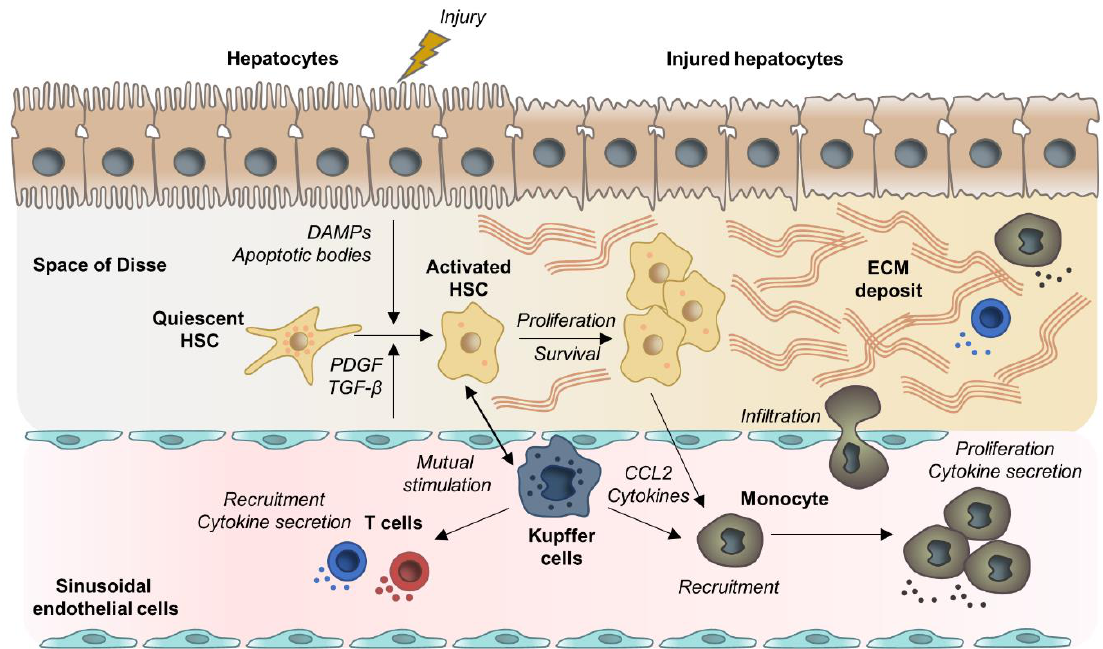
Figure 1. Examples for mechanistic concepts for liver fibrosis. Chronic hepatocyte injury causes release of damage-associated patterns (DAMPs) and apoptotic bodies that activate Hepatic stellate cells (HSCs) and recruit immune cells. Complex multidirectional interactions between activated HSCs and Kupffer cells, as well as innate immune cells promote trans-differentiation into proliferative and extracellular matrix (ECM) producing myofibroblasts. Abbreviations: PDGF: Platelet Derived Growth Factor; TGF-β: Transforming Growth Factor Beta; CCL2: chemokine (C-C motif) ligand 2.